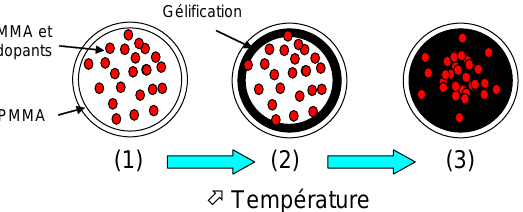
Figure 4. Interfacial gel polymerization method used by Koike et al.